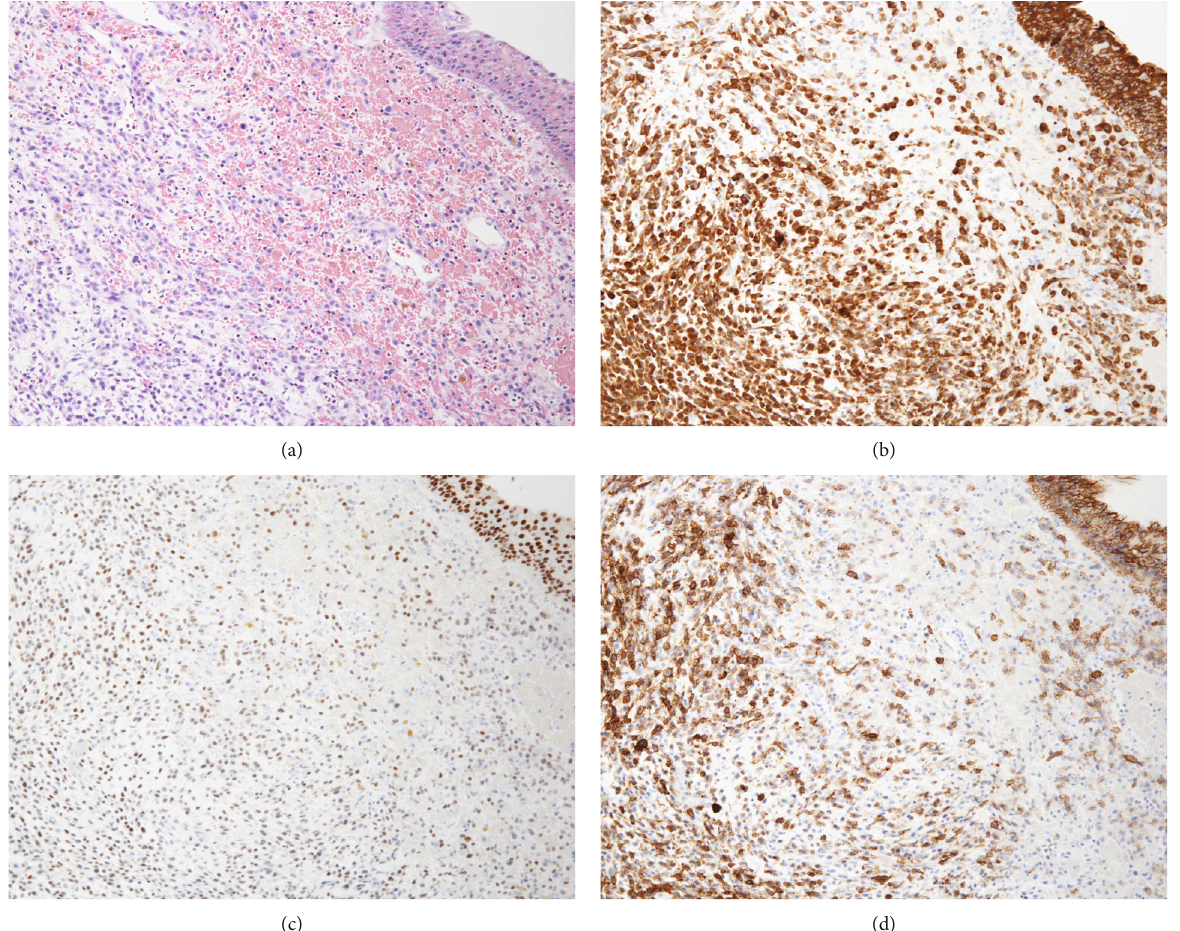
Figure 2: (a) HE staining of the tumor when transurethral electrocoagulation was performed. (b – d) Immunohistochemical staining fi ndings of the tumor for pancytokeratin (b), GATA3 (c), and CD138 (d) when transurethral electrocoagulation was